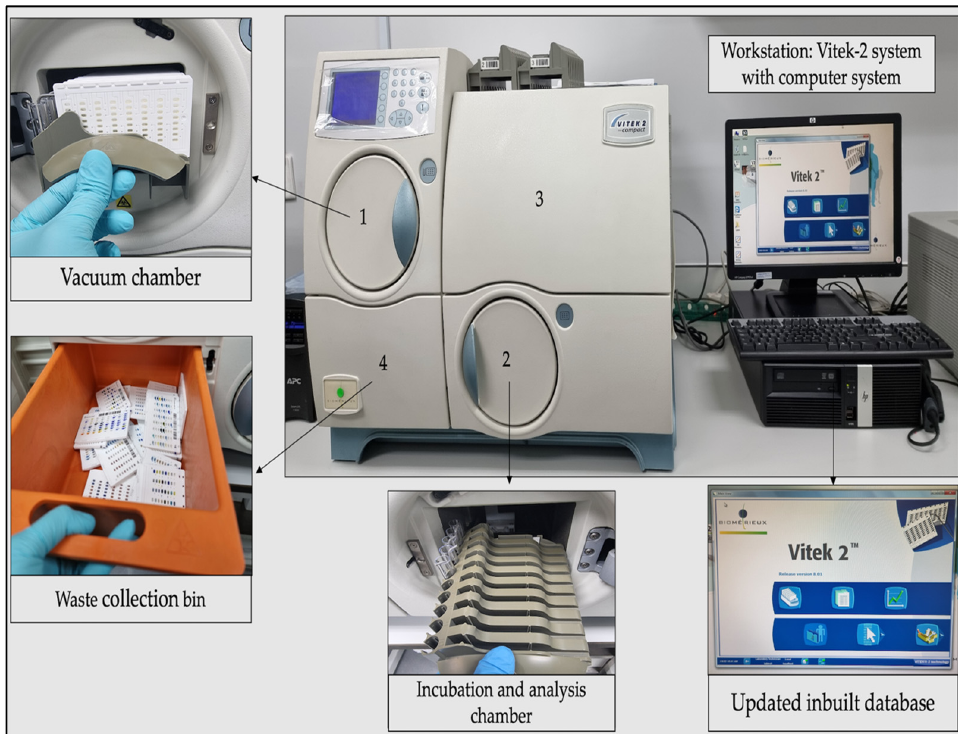
Figure 2. Workstation VITEK 2 system with computer system. Note: 1—fill door; 2—load door; 3—front user access door; 4—waste collection door.